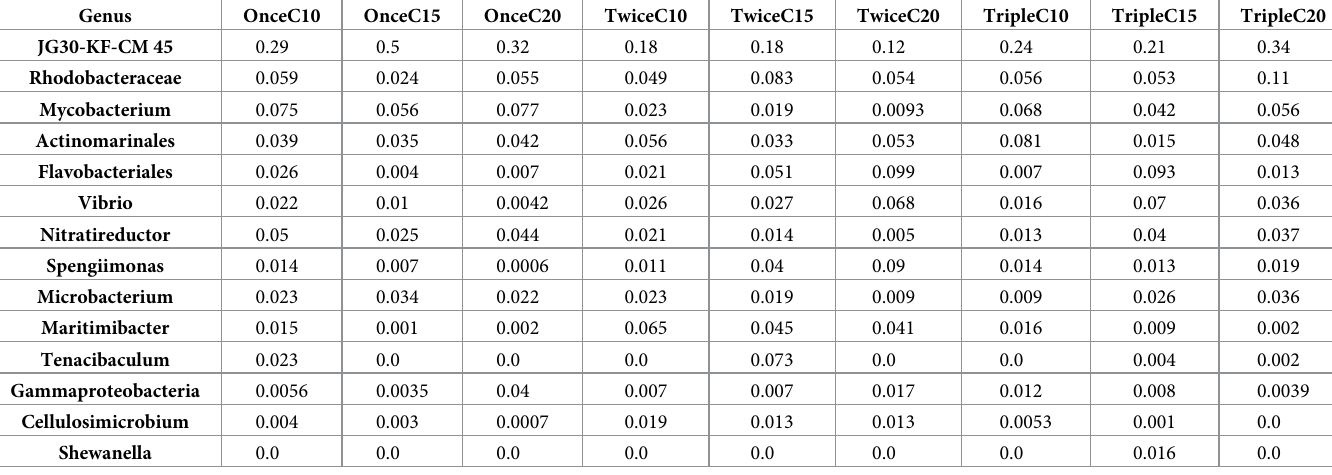
which including the Gram-negative enteric bacteria ( Escherichia coli , Salmonella typhimur- ium ) [71]. In fact, proline contributes to the pathogenesis of various pathogenic bacteria [72]. Since an interruption of proline metabolism ( Δ 1-pyrroline-5-carboxylate) and uptake attenu- ates virulence of certain pathogens [72]. In our study, T9 showed the highest proline level, and lower pathogenic abundance of Tenacibaculum, thus proline availability may indicate for the lower pathogenic bacterial abundance. On the other hand, proline amino acid also serves as a Table 7. Relative abundance of the most prevalent bacterial genera identified in the intestine of Litopenaeus vannamei reared in